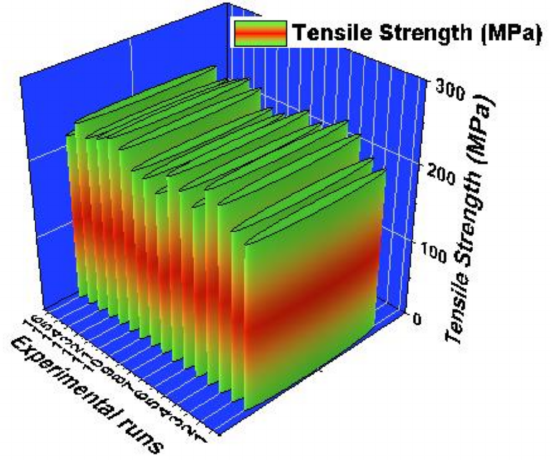
Figure 15. 3D bar plot: experimental runs vs. tensile